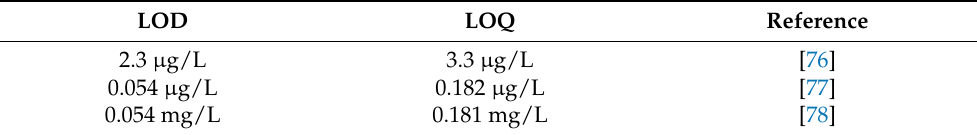
Table 7. LOD and LOQ of Pb(II) by FAAS in the literature.